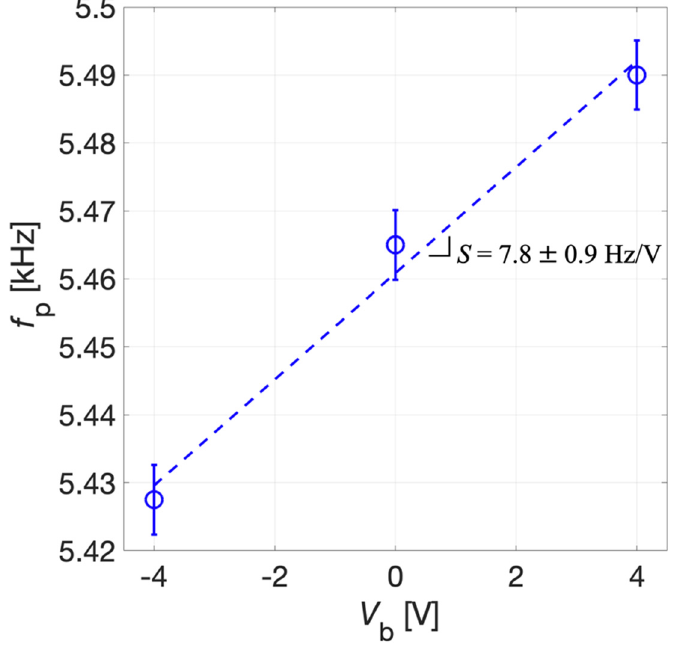
Figure 13. Measured parallel resonant frequency f p (circles) and linear fitting (dotted line) as a function of V b . The error bars extend one standard deviation σ on each side of the experimental data.